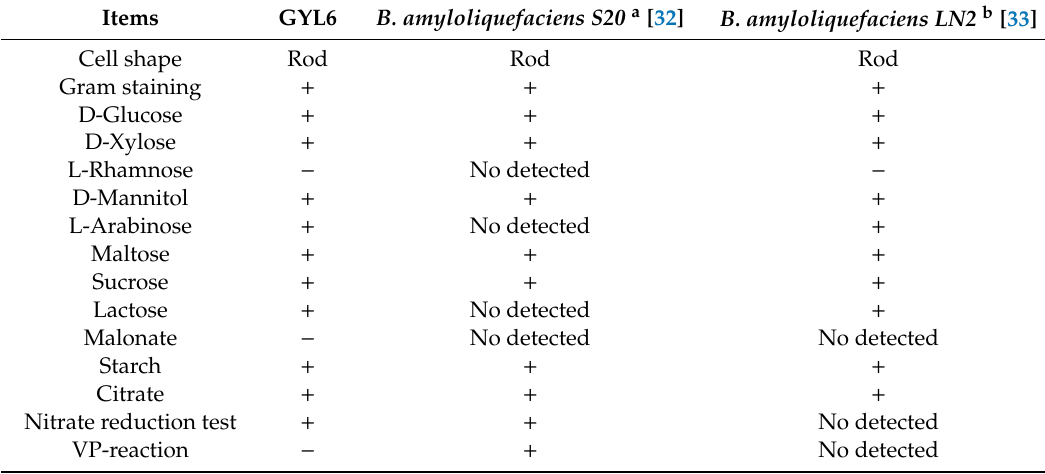
Table 3. The morphological and biochemical characteristics of GYL 6 and other B. amyloliquefaciens. Items